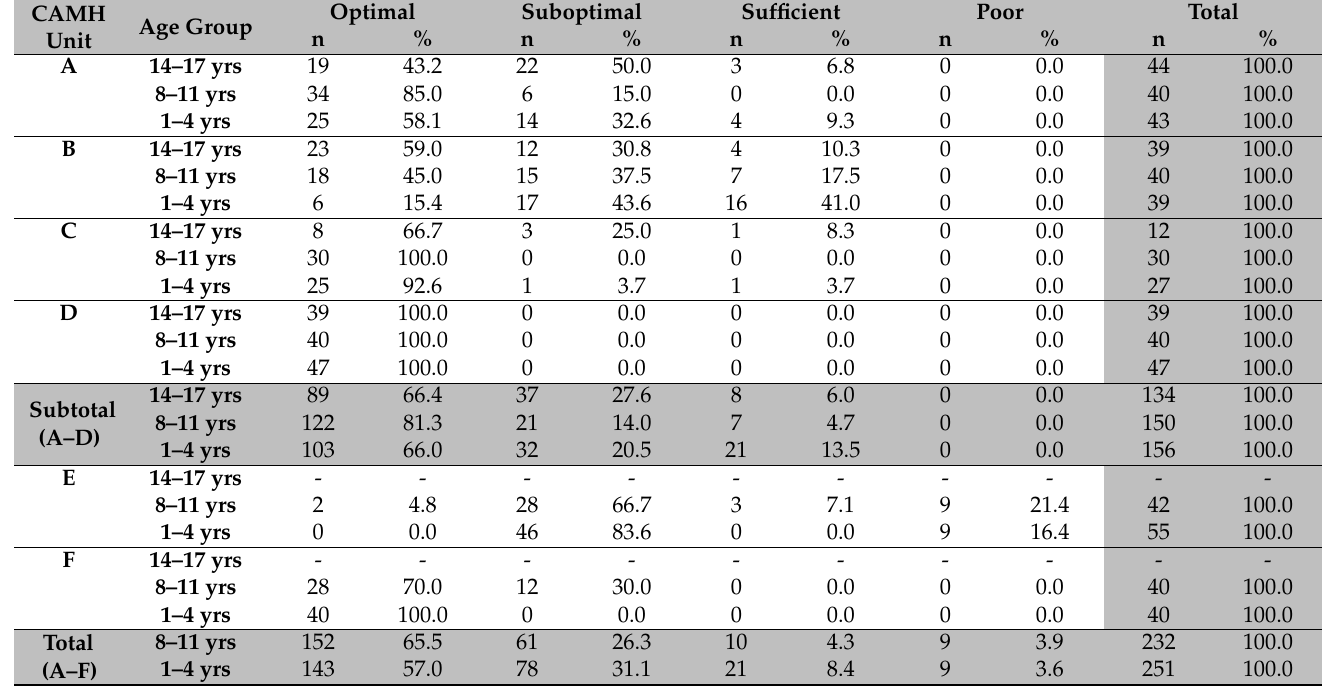
Table 6. Frequency of subjects by the composition/quality of the teams providing ASD diagnosis, CAMH unit and age group.